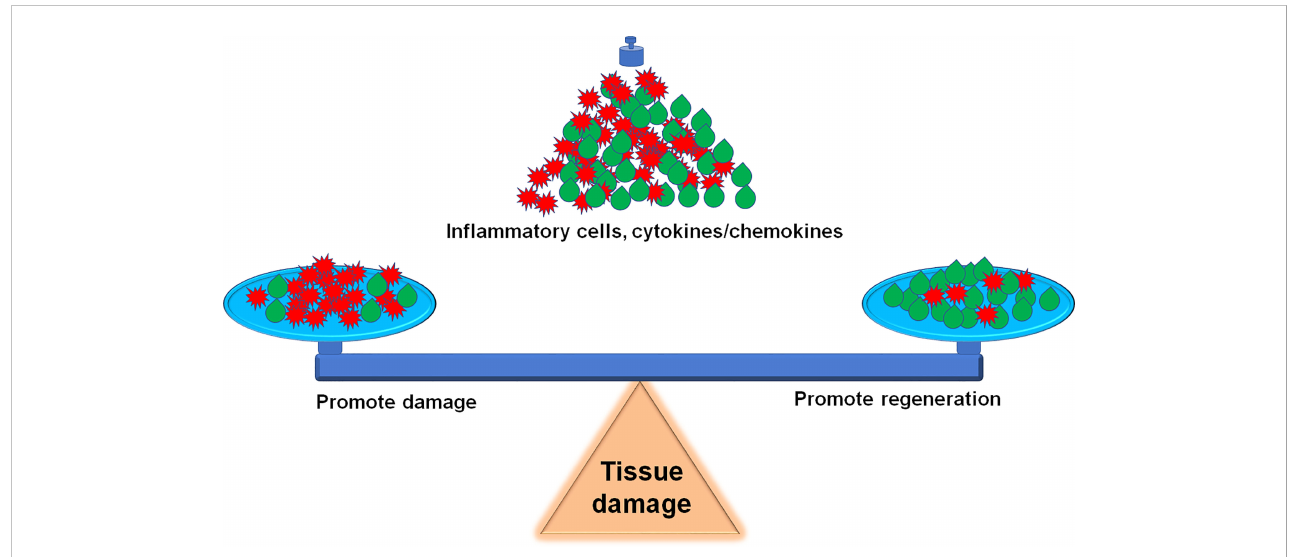
FIGURE 3 In fl ammation balance in skeletal muscle damage and repair. How to accurately balance the bene fi cial and detrimental effect of in fl ammation during the skeletal muscle damage and repair is a challenge for precise therapeutic